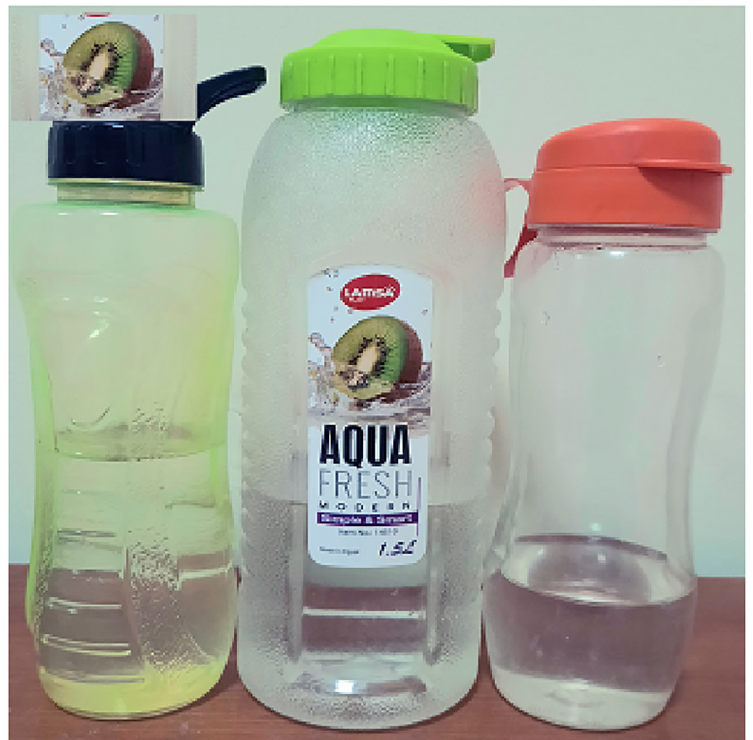
Fig 3. Correlation pattern